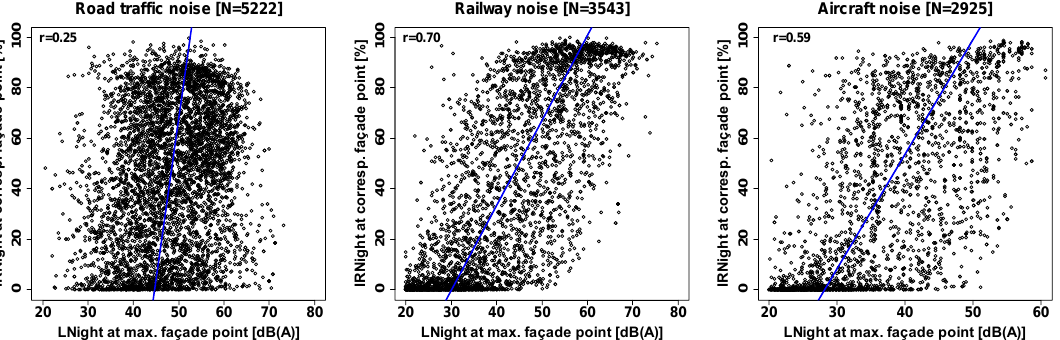
Figure 2. Scatterplots incl. total least squares (i.e., ‘orthogonal’ or ‘major axis’) regression line (blue) of LNight vs. façade-point-corresponding IRNight for road traffic, railway, and aircraft noise exposure in the present sample. Corresponding correlation coefficients are given in the top left corner of each plot. Table 2. Number of cases ( N ) per LNight category, percent of sample in that category, and observed %HSD in each category. LNight refers to the maximum façade point of the dwelling unit.